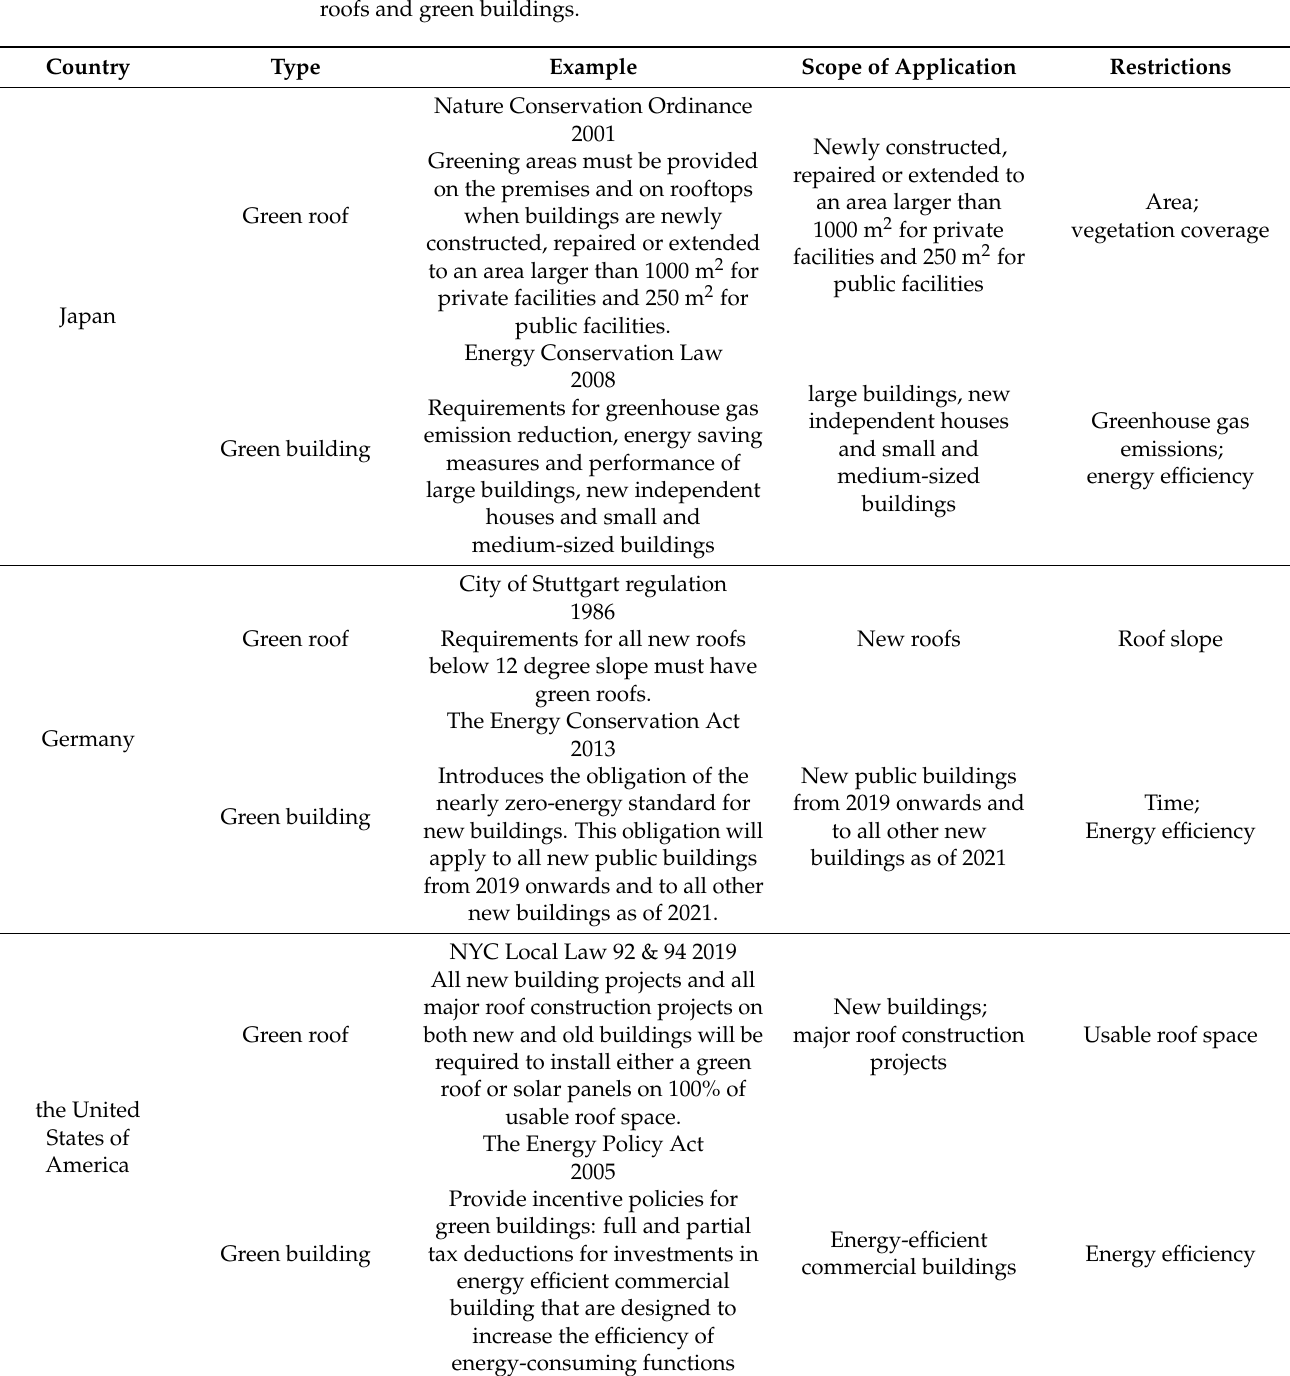
Table A1. Comparison of mandatory laws and regulations encouraging the construction of green roofs and green